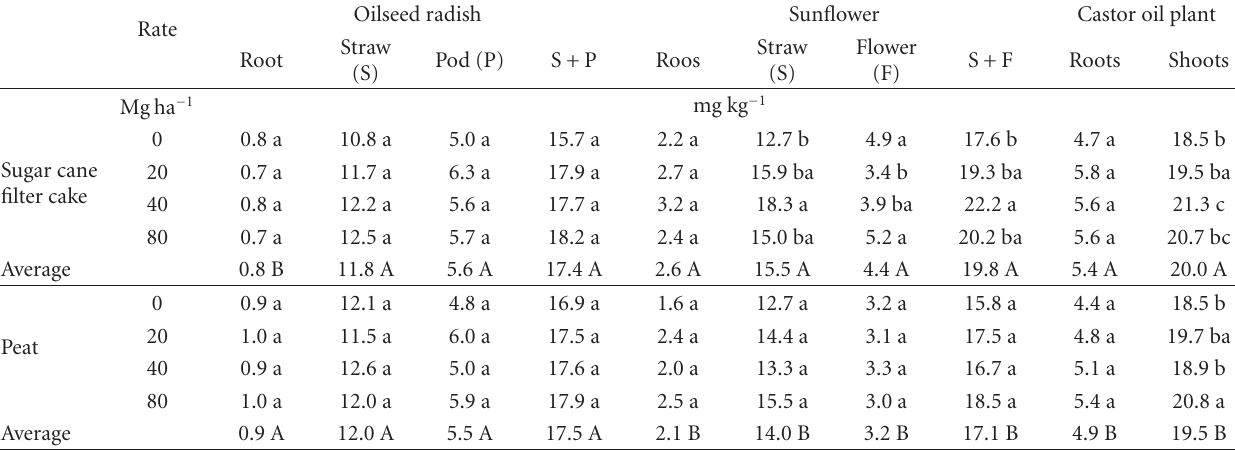
Table 4: Dry matter yield for di ff erent plant parts of the species tested according to the rate of organic material treatment ∗ .